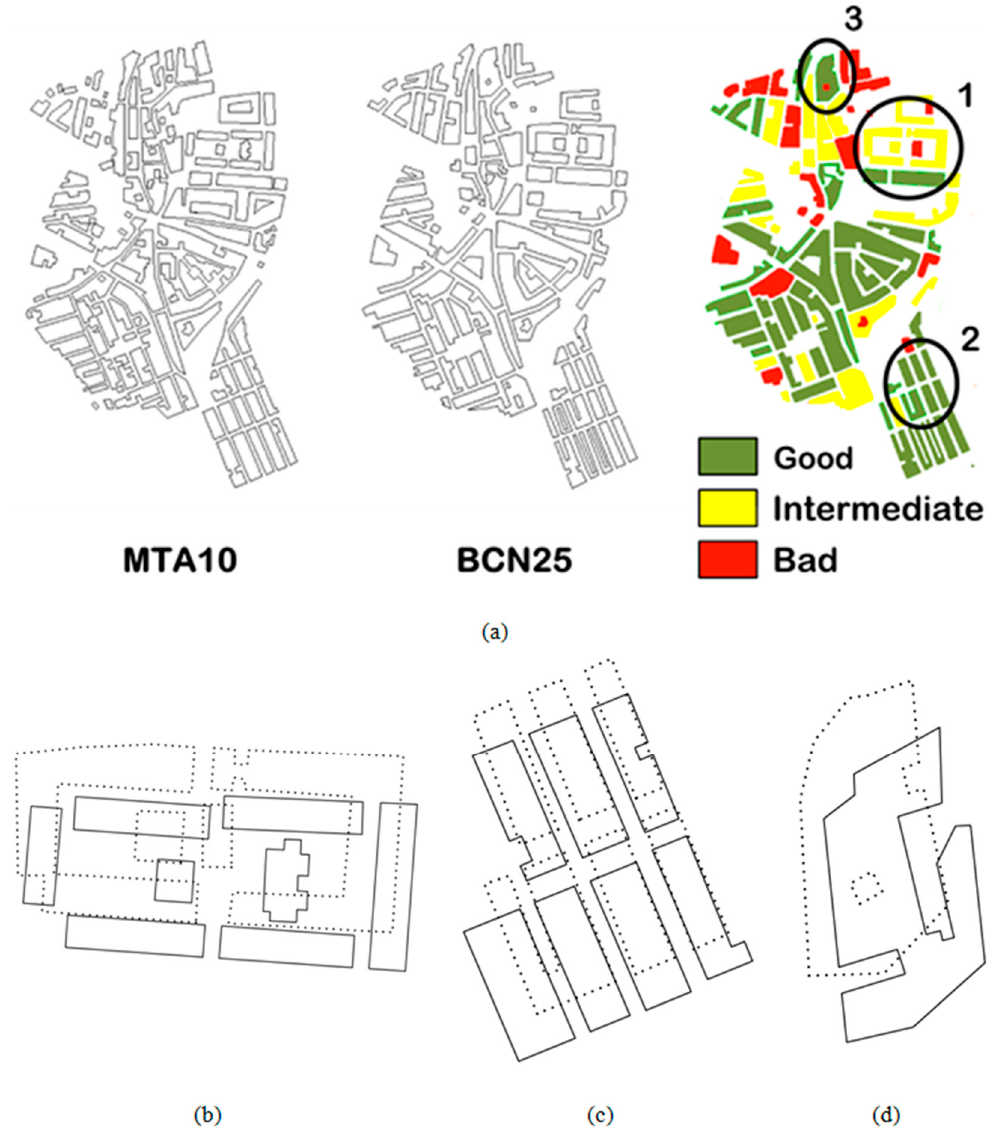
Figure 9. ( a ) Spatial distribution of matched polygons according to MAV values (Alhaurín de la Torre, 1066 sheet). ( b – d ) Enlargement of Zones 1, 2 and 3, respectively (not at a defined scale). Continuous lines represent MTA10, and dot lines represent BCN25.